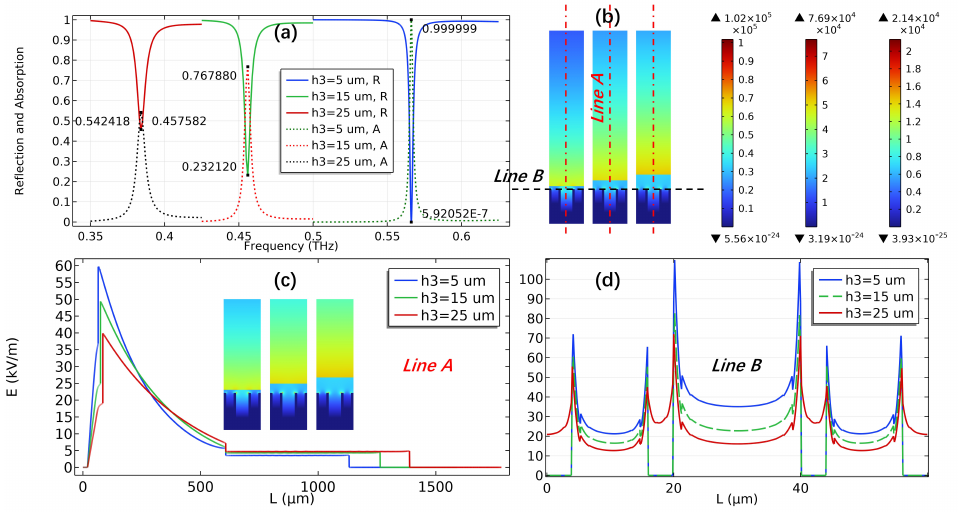
Figure 11. Reflection and absorption spectra ( a ), surface electric field distribution ( b ) and electric field diagrams along Line A ( c ) and Line B ( d ) of SSPPs with di ff erent sample thicknesses ( h 3 = 5 µ m, 15 µ m, 25 µ